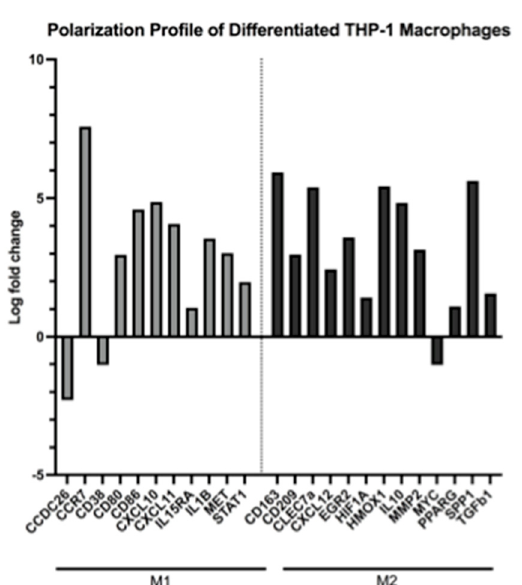
Figure 2. Histogram of select differentially expressed genes involved in M1 ( left ) or M2 ( right ) macrophage polarization according to the literature. Each bar represents the log fold change per gene as expressed in untreated macrophages compared to untreated monocytes. DEGs were included with p < 0.05 and FDR < 0.05.